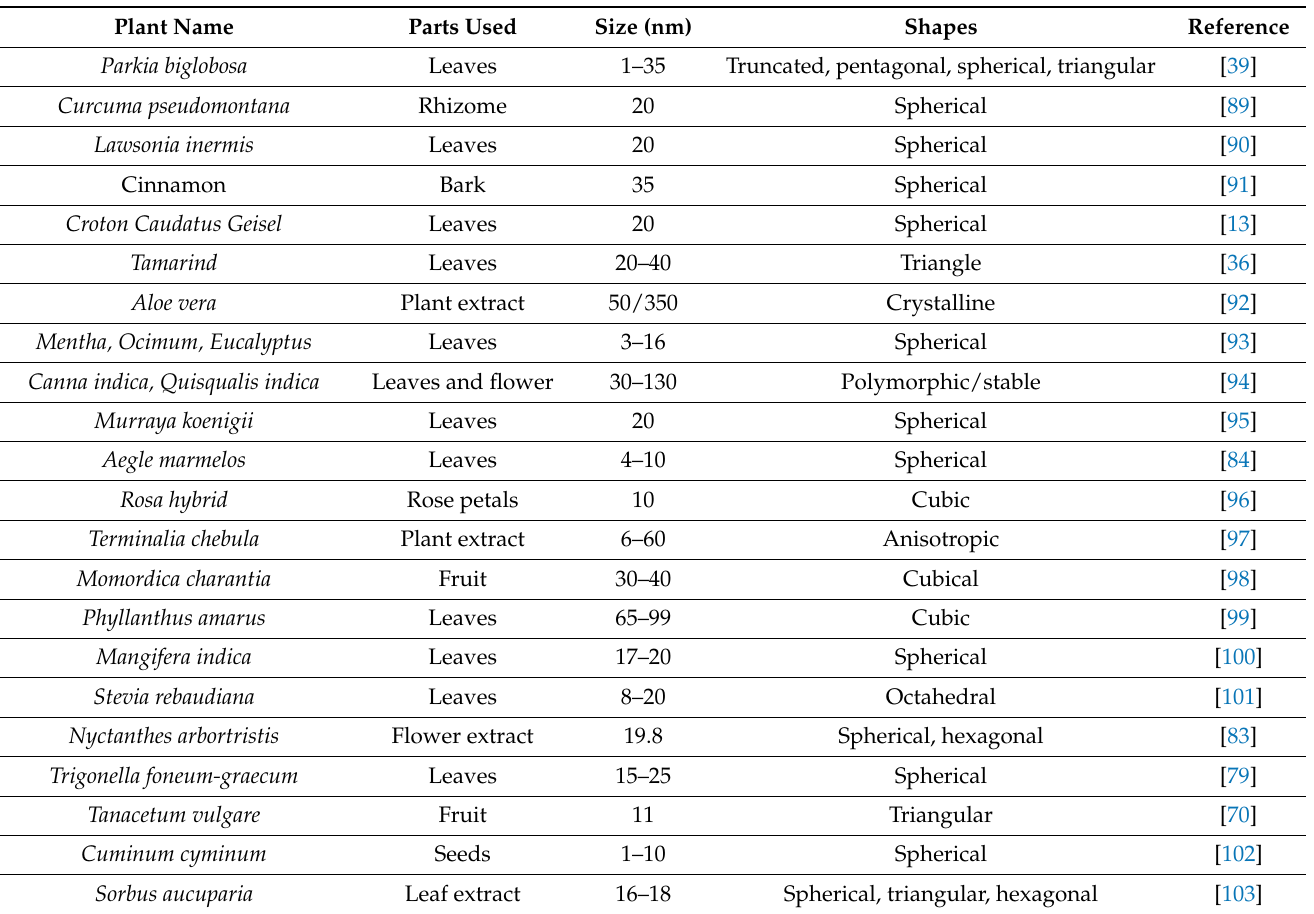
Table 2. Plant-assisted synthesis of gold